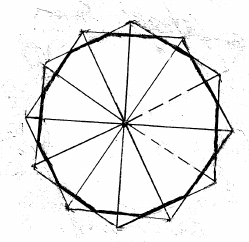
Figure 4. The regular duodecagon K and the stellated regular duodecagon K ∗ = K ∗ rotating the quadrilateral Q 4,4,4 through an angle 2 π /12 around the origin.